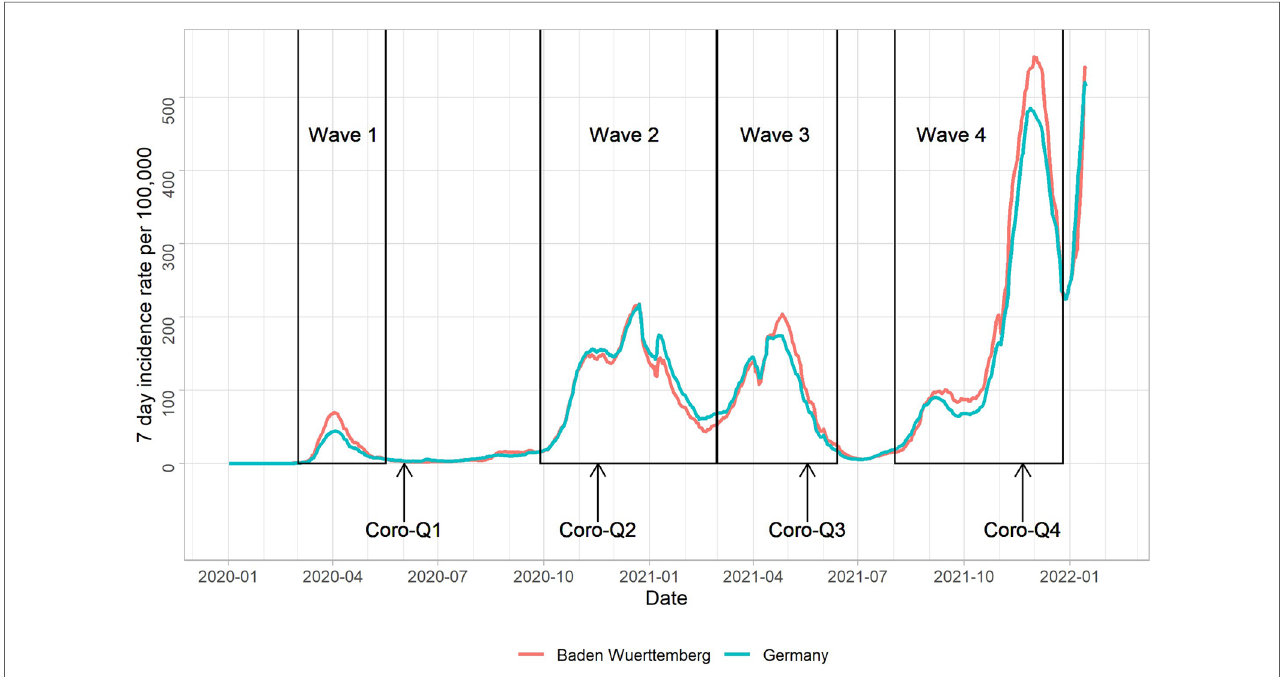
FIGURE 1 Timing of Coro-Q surveys and 7-day incidence rates of SARS-CoV2 infections in Germany and the state of Baden-Württemberg (residence area of TREND participants) as reported by the Robert-Koch-Institute.